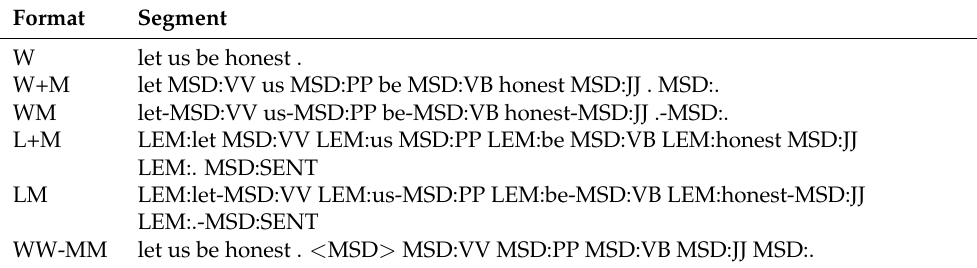
Table 4. An example segment in the different formats of the